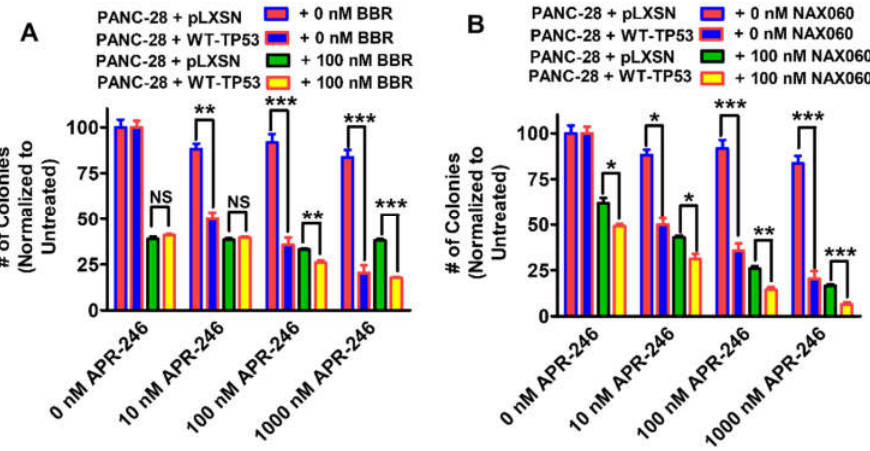
Figure 17. Both berberine and NAX60 can increase the effects of APR-246 on clonogenicity of PANC-28 cells in the presence WT-TP53, but in the absences of WT-TP53 they have less effects on clonogenicity. The effects of ABR-246 on clonogenicity in the presence of low doses of BBR (Panel ( A )) or NAX060 (Panel ( B )) were examined. PANC-28 + pLXSN in the absence of BBR or NAX060 (red bars), PANC-28 + WT-TP53 in the absence of BBR or NAX060 (blue bars), PANC-28 + pLXSN in the presence of APR-246 and 100 nM BBR (green bars), MIA-PaCa-2 + WT-TP53 in the presence of APR-246 and100 nM NAX060 (Panel ( B )) (yellow bars). The colony formation abilities were repeated 3 times for each cell type and each treatment condition and similar results were observed. *** = p < 0.0001, ** p < 0.005, * p < 0.05 and NS = not statistically significant.